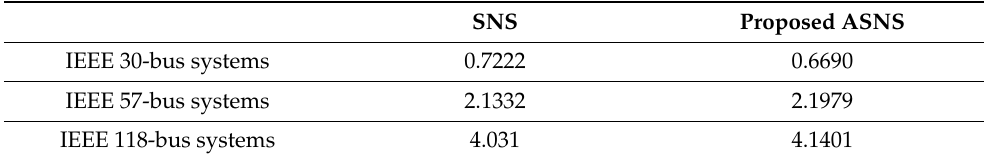
grid. Table 13. Average computational time per iteration using ASNS and